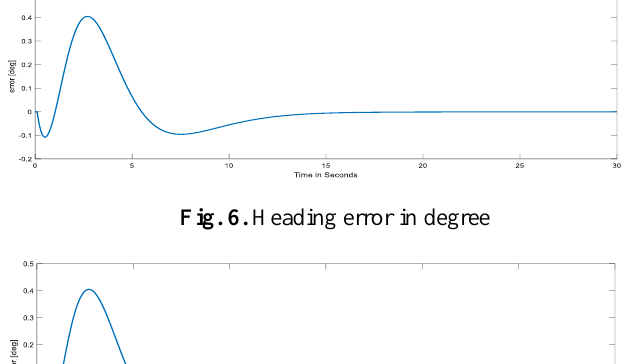
Fig. 6. Heading error in degree